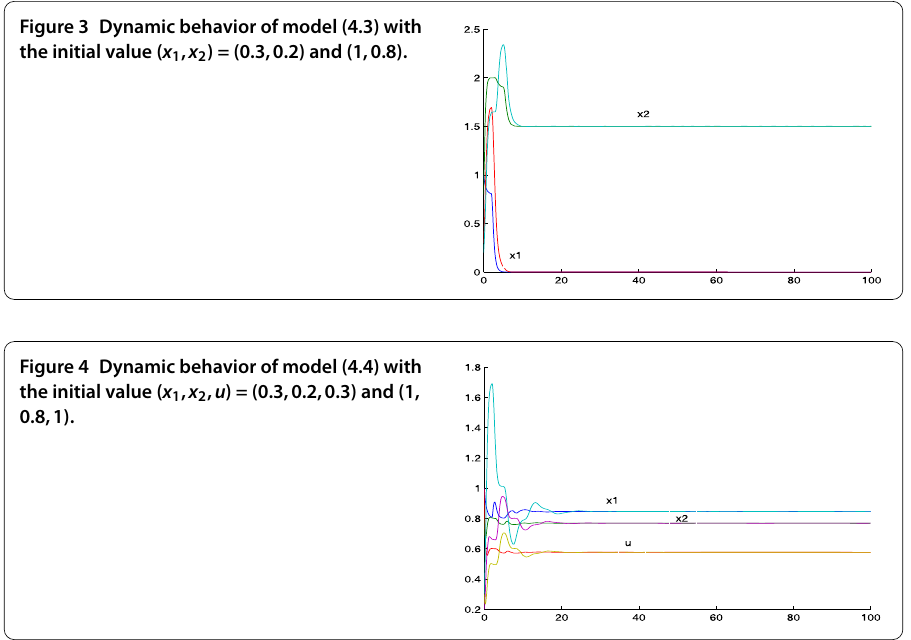
Figure 4 Dynamic behavior of model (4.4) with the initial value ( x 1 , x 2 , u ) = (0.3,0.2,0.3) and (1,